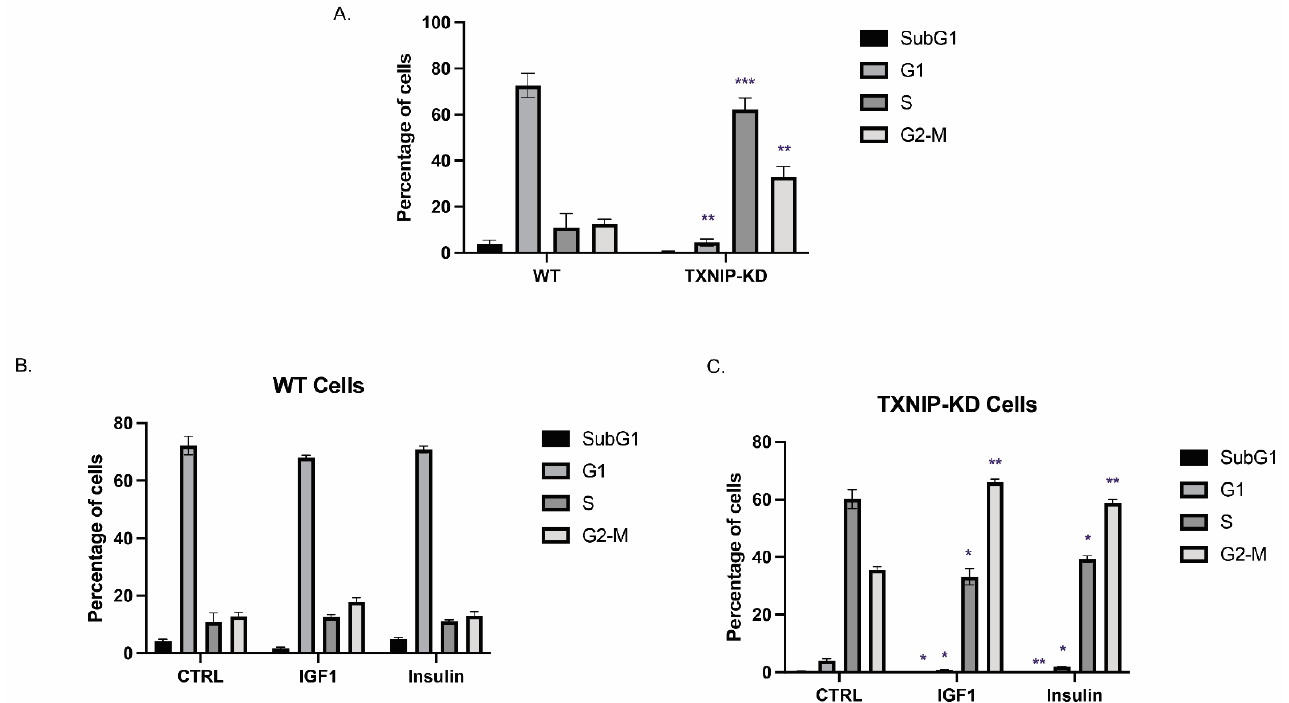
Figure 2. Effect of TXNIP on cell cycle distribution. ( A ) TXNIP-KD and wild-type HEK293t cells were starved for 24 h, after which they were subjected to cell cycle analysis using flow cytometry. Quantitative analysis of the proportion of the cells in each phase was performed from at least 10,000 cells per sample. ( B , C ) Wild-type ( B ) and TXNIP-KD HEK293t ( C ) cells were starved for 24 h, after which they were treated with IGF1 or insulin for an additional 24 h. Flow cytometry analysis of cell cycle shift by hormone treatment was then performed. * p - value ≤ 0.05; ** p - value ≤ 0.01; *** p -value ≤ 0.001.